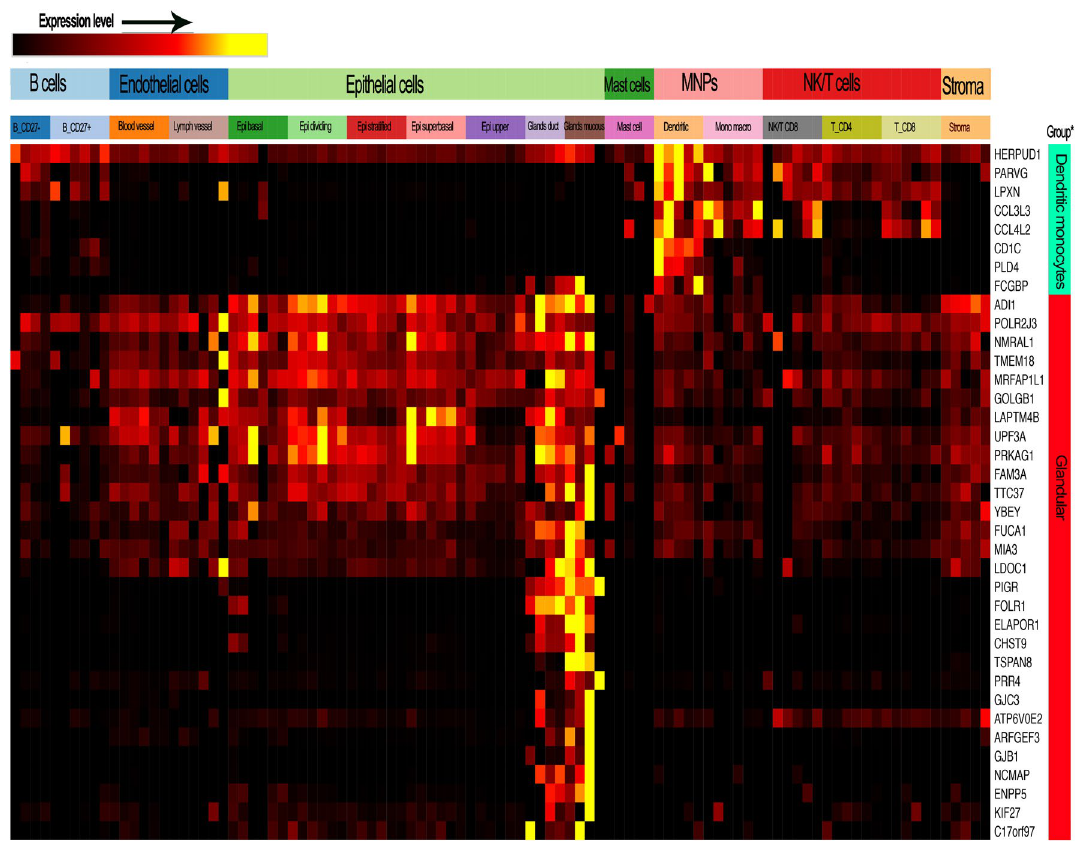
Figure 4. Esophageal genes that are differentially expressed in African Americans and European American samples correspond to genes known to be expressed in specific cell types. Genes upregulated in African American versus European American esophagus mapped to two cell lineages with prominent presence in the esophageal tissue stability dataset of the human cell atlas (https:// data. human cella tlas. org/). One significant fraction of the African American-upregulated gene signature maps to glandular mucous epithelial cells of esophageal glands (genes marked by red, far right bar). Expression of several of the genes upregulated in